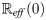
Initial effective reproduction number, Reff(0) changing with immunity in humans.The Reff(0) decreases as the immunity in humans increases and Ae. aegypti are infected with Wolbachia. This indicates that even though infecting the mosquitoes with Wolbachia might not reduce the initial R0 to be less than one, it could be an effective strategy in future seasonal outbreaks to bring Reff to be less than one when part of the population is immune. (a) Reff(0) for DENV transmitted by Ae. aegypti mosquitoes. (b) Reff(0) for DENV transmitted by Ae. albopictus mosquitoes. (c) Reff(0) for CHIKV transmitted by Ae. aegypti mosquitoes. (d) Reff(0) for CHIKV transmitted by Ae. albopictus mosquitoes. (e) Reff(0) for ZIKV transmitted by Ae. aegypti mosquitoes. (f) Reff(0) for ZIKV transmitted by Ae. albopictus mosquitoes.